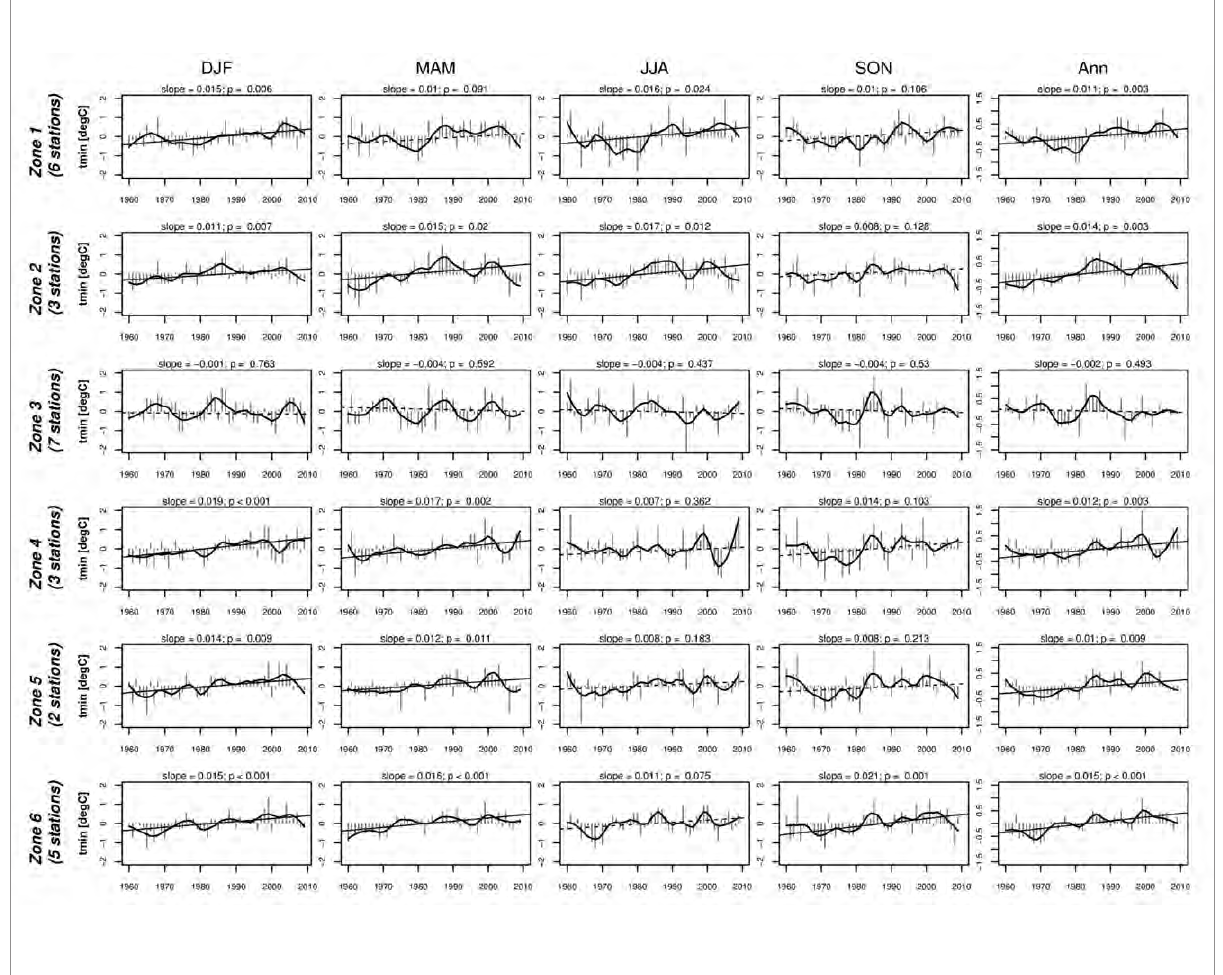
Figure 8: Regional mean time series and trends in mean daily minimum temperature (tmin, °C) for stations in the six water management zones for summer (DJF), autumn (MAM), winter (JJA), spring (SON) and annual (Ann) means. Grey bars represent departures from the 1960–2010 mean for each year. Black curves are a Loess smoothing of the yearly data with a bandwidth of 0.25. Trend lines are shown for the Sen’s slope estimate. Solid trend lines indicate the trend is significant at the 5% level and dashed lines are not significant at this